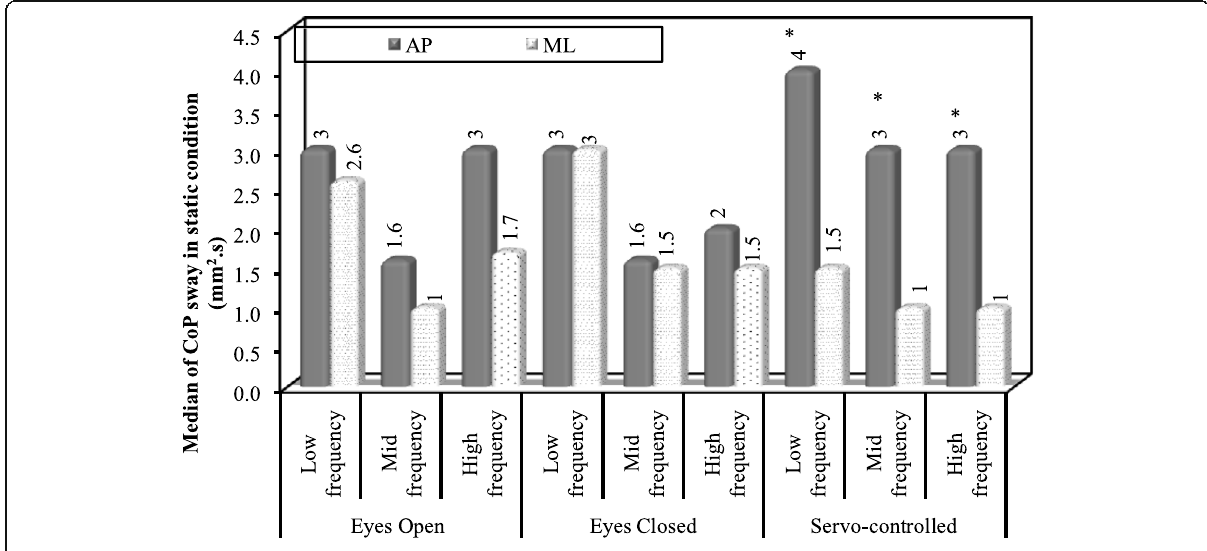
Fig. 3 Comparison of FFT of AP and ML sway in the study group in the static conditions